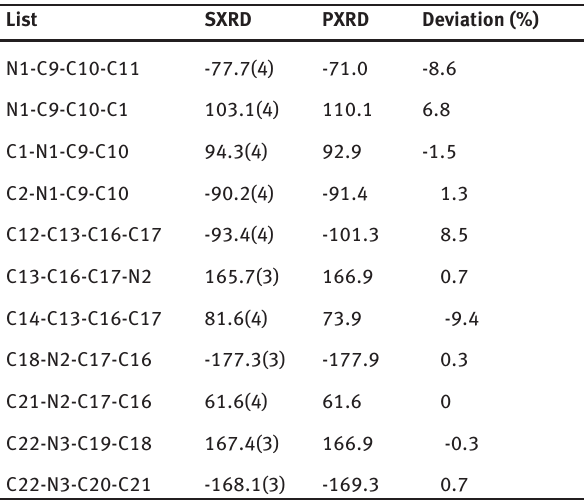
Table 4: Selected Torsion angles (°) for based on both single-crystal X-ray diffraction and powder X-ray